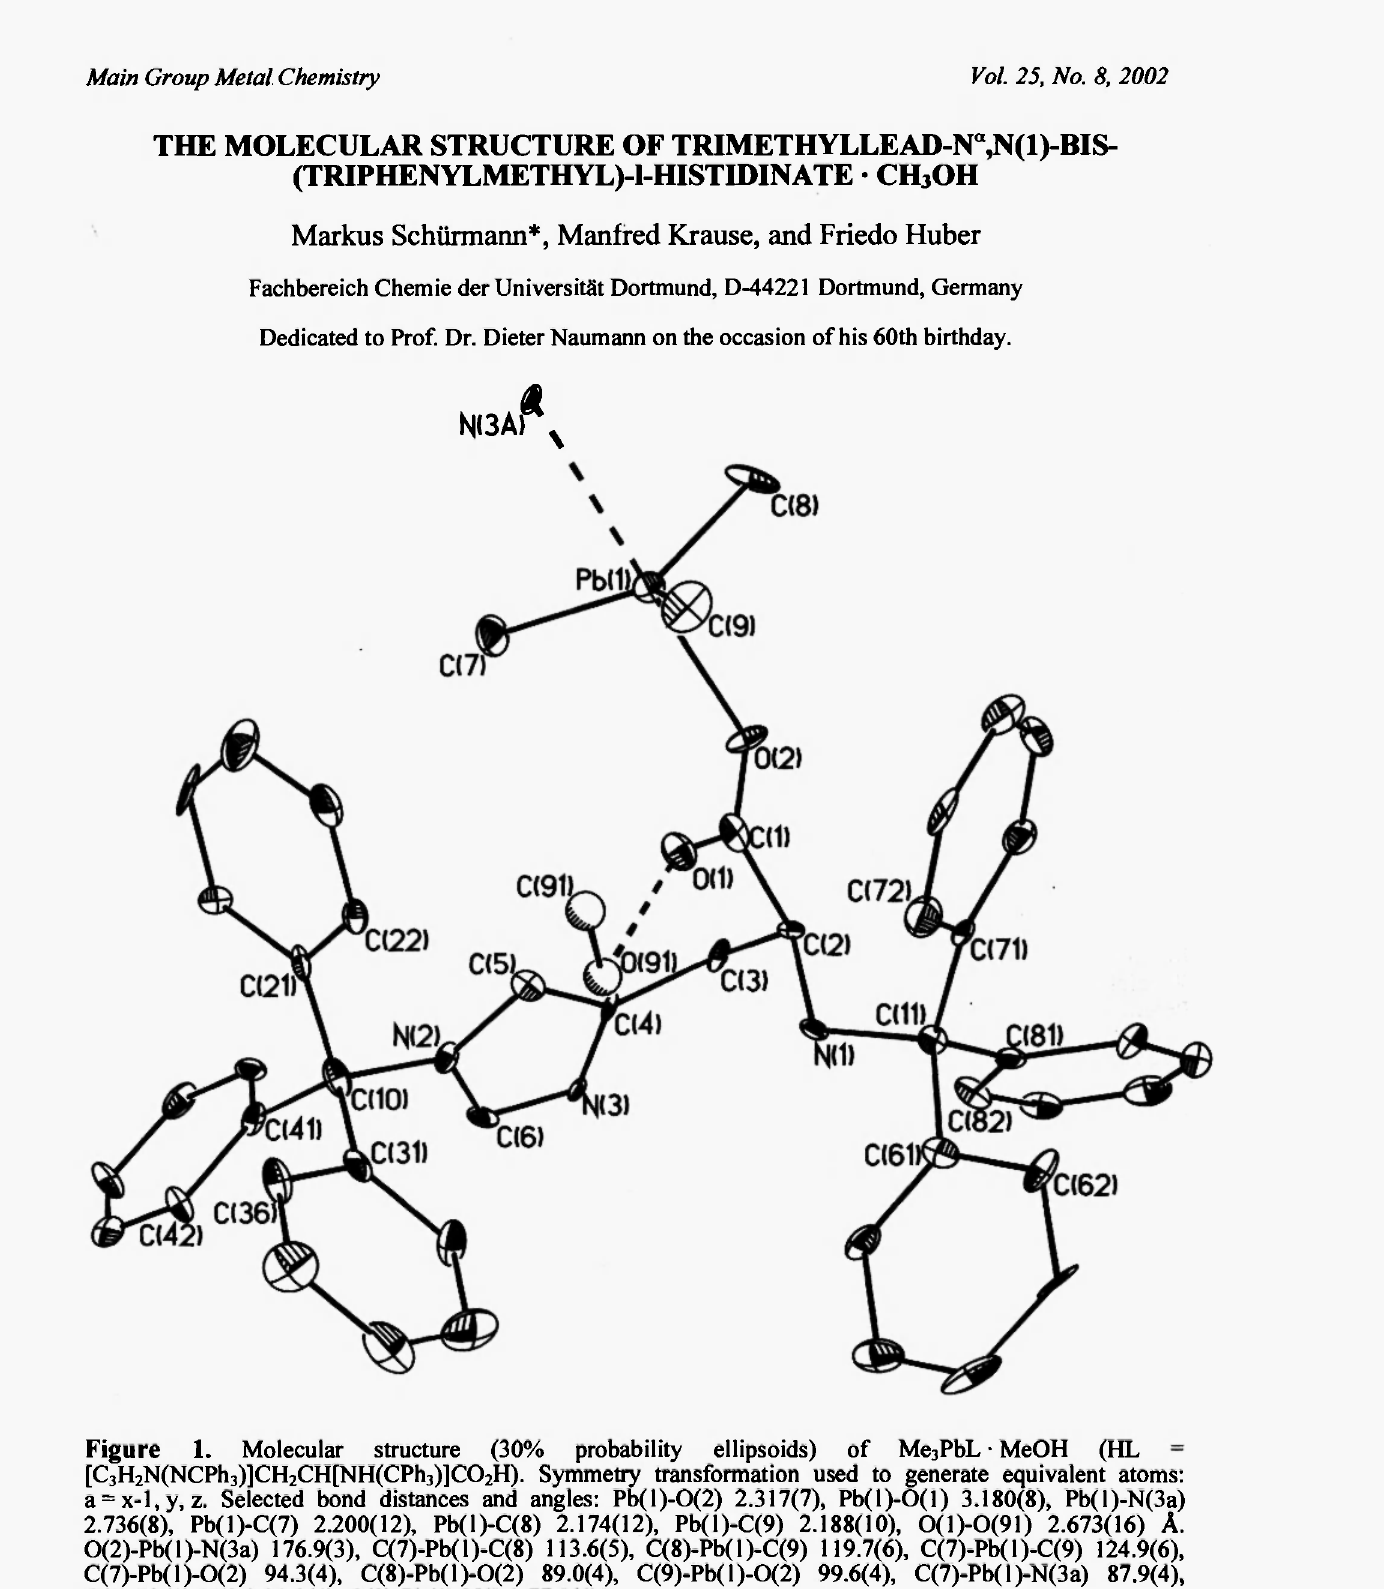
Figure 1. Molecular structure (30% probability ellipsoids) of Me